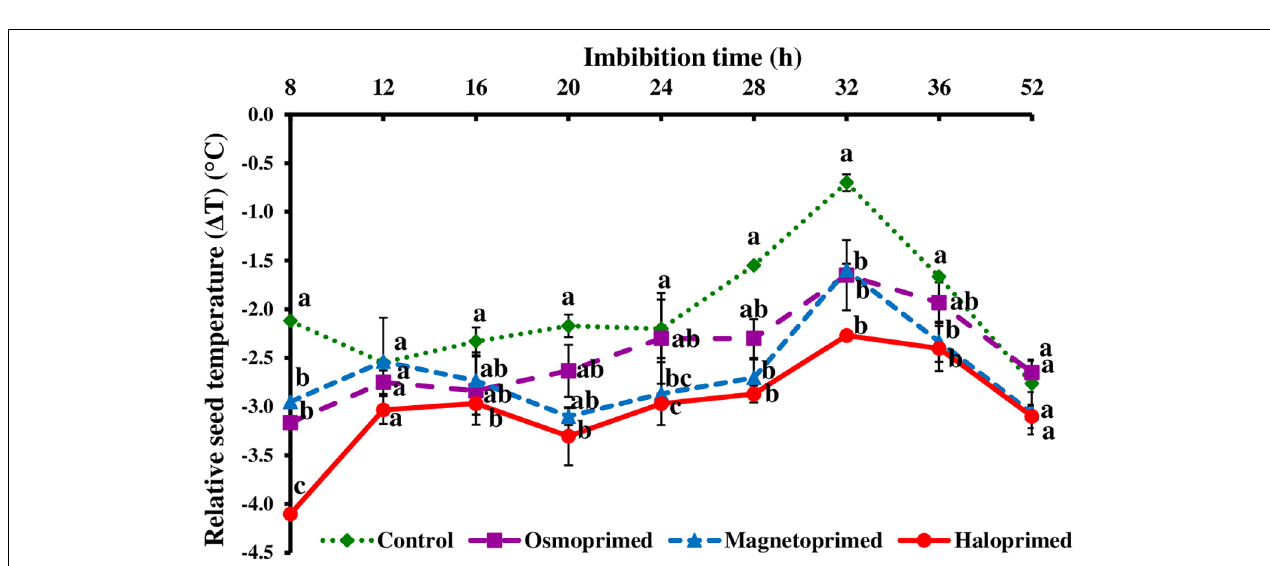
FIGURE 1 | Emergence index of differently primed onion seeds. Data represent mean ± SE of four biological replications. Different letters over the bars indicate significant differences among means based on LSD test ( p < 0.05).